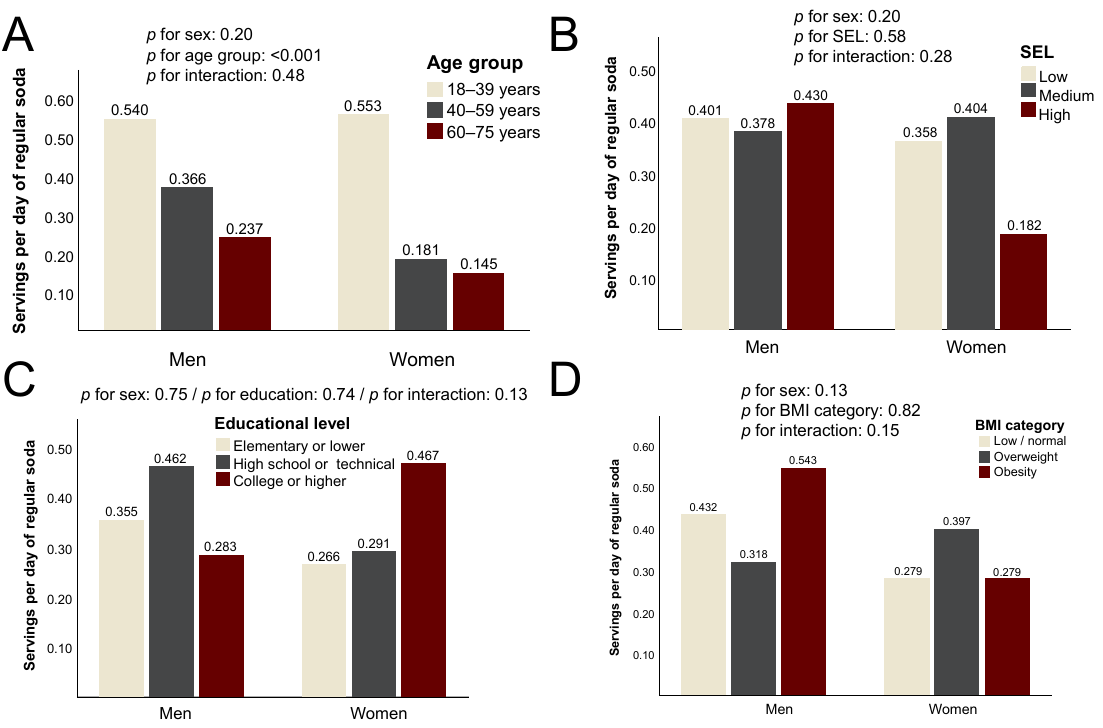
Figure 1. Total daily consumption of calories from sugary drinks among the study participants. Data are mean daily Calories from sugar ‐ sweetened beverages according to ( A ) age group; ( B ) socioeco ‐ nomic level (SEL); ( C ) educational level; ( D ) body mass index (BMI) category. Regular soda was similarly consumed in both sexes and was not significantly associ ‐ ated with SEL, educational level or body mass index category ( p > 0.05 for all). There was a significantly lower intake of regular soda with increasing age group in both sexes ( p < 0.001 in both cases) (Figure 2). Despite a trend towards a higher intake of regular soda in women with a lower household SEL or higher education, none of these differences reached statistical significance.